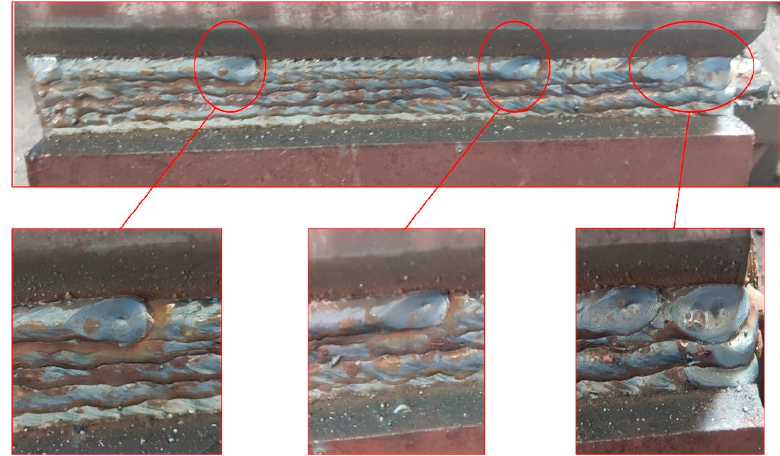
Figure 23. Local close-up of arc closing position of segmental lapping.